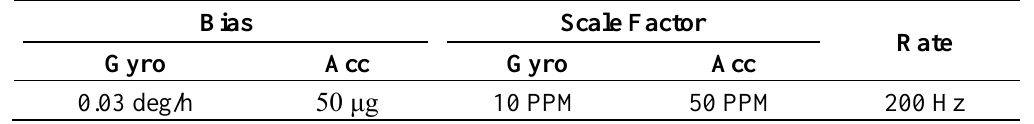
Table 1. Inertial sensors specifications.